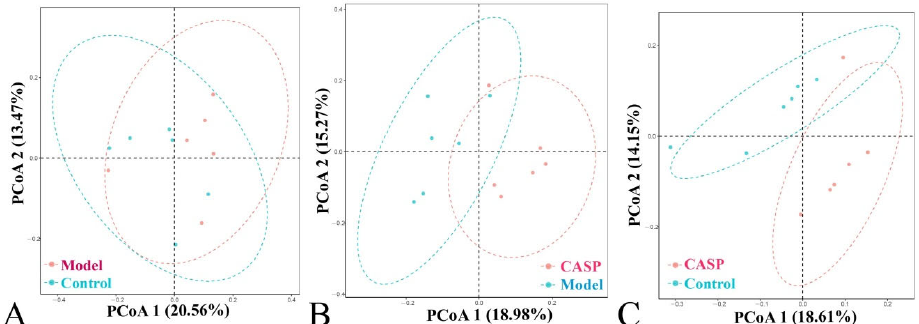
Figure 8. Principal coordinate analysis of cecum content floras in each group. Note: ( A ) PCoA dia ‐ gram of the normal control group and the model group; ( B ) PCoA diagram of the model group and the intervention group of CASP; ( C ) PCoA diagram of the normal control group and the interven ‐ tion group of CASP. group of CASP.